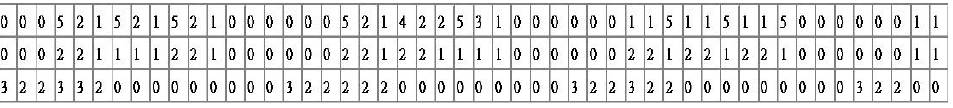
Figure 7. Feature representation of the 3D model (based on N = 50 and Hollow feature calculation).